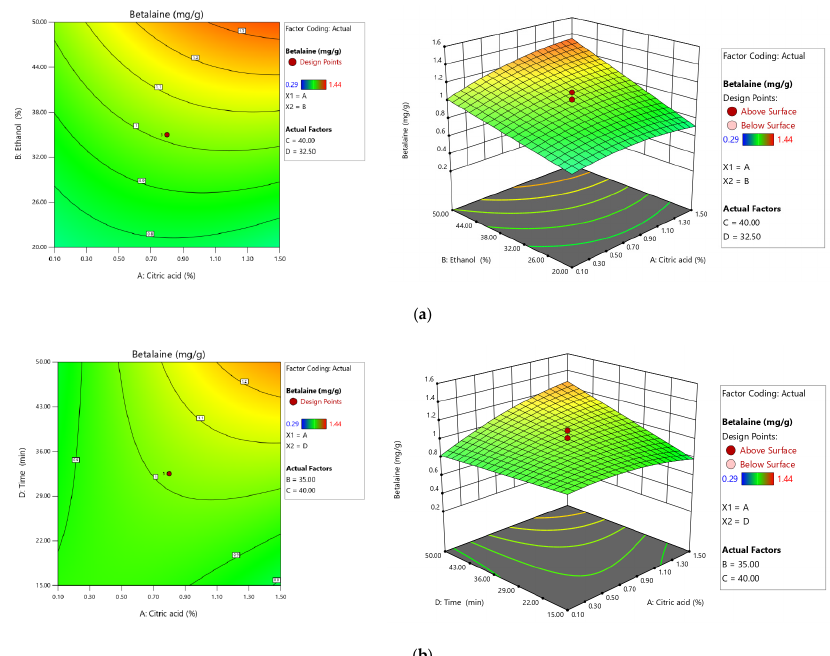
Figure 1. Second-order contour plots ( left ) and 3D surface plots ( right ) screening the effect of ethanol and citric acid con- centration ( a ) and extraction time and citric acid concentration ( b ) on the extraction yield of total betalain content (BT). In analyzing the deviation from the reference point, a slope with a large or curved inclination for a specific factor shows that the response is sensitive in this case, while a relatively flat line demonstrates insensitivity to changes in this factor. The main factor affecting BT extraction is the ethanol (Figure 2a, curve B) followed by temperature (Figure 2a, curve C) and extraction time (Figure 2a, curve D). Meanwhile, the findings showed that citric acid is less sensitive (Figure 2a, curve A).